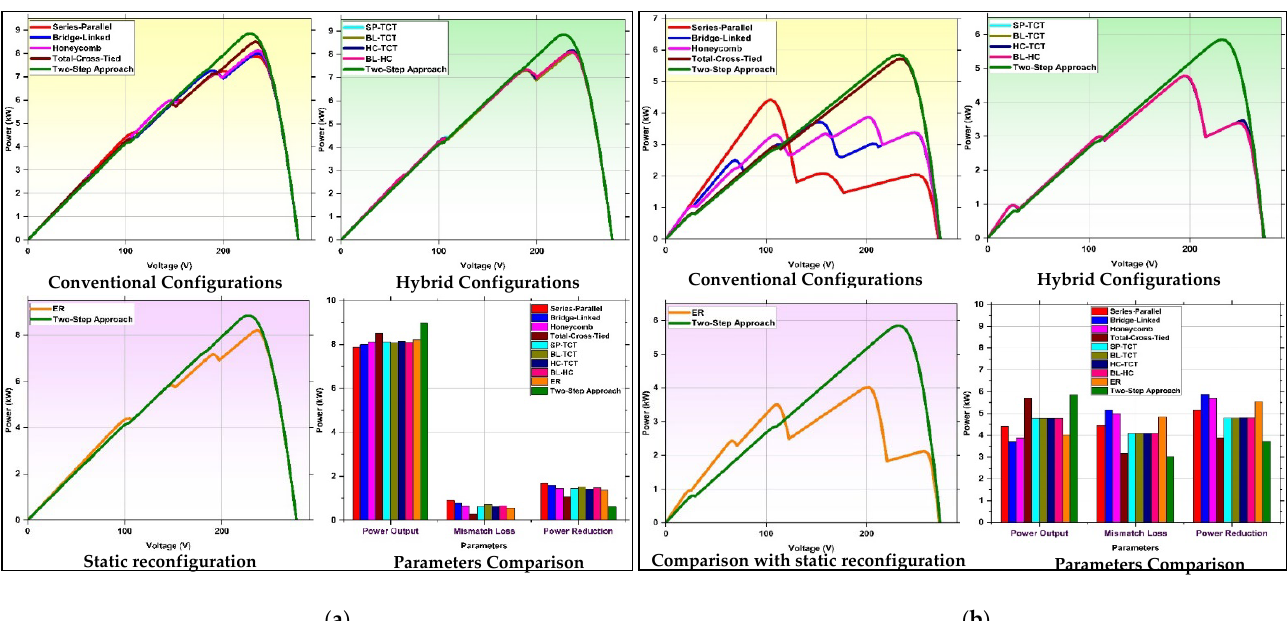
Figure 15. Graphical comparison of the two-step approach with conventional, hybrid configurations and static reconfiguration technique for partial shading: ( a ) S4 and ( b ) S5. The summarized data for the different parameters of the conventional and hybrid configuration, static electrical reconfiguration, and the two-step approach for the five partial shading cases are given in Table 4. Table 4. Summarized data of the results obtained for the five partial shading cases.